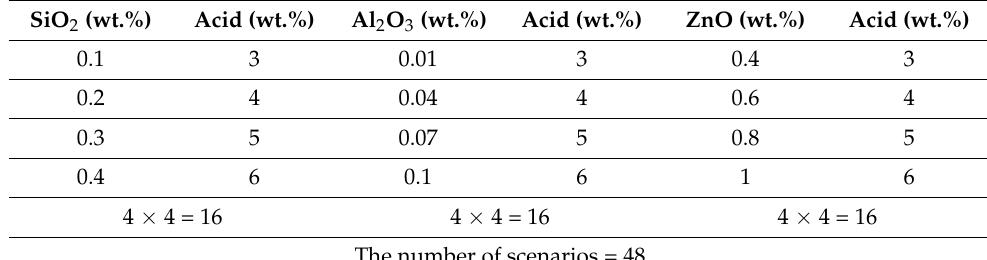
Table 5. Scenarios of Hybrid Nano-Acid Fluids (HNAF).